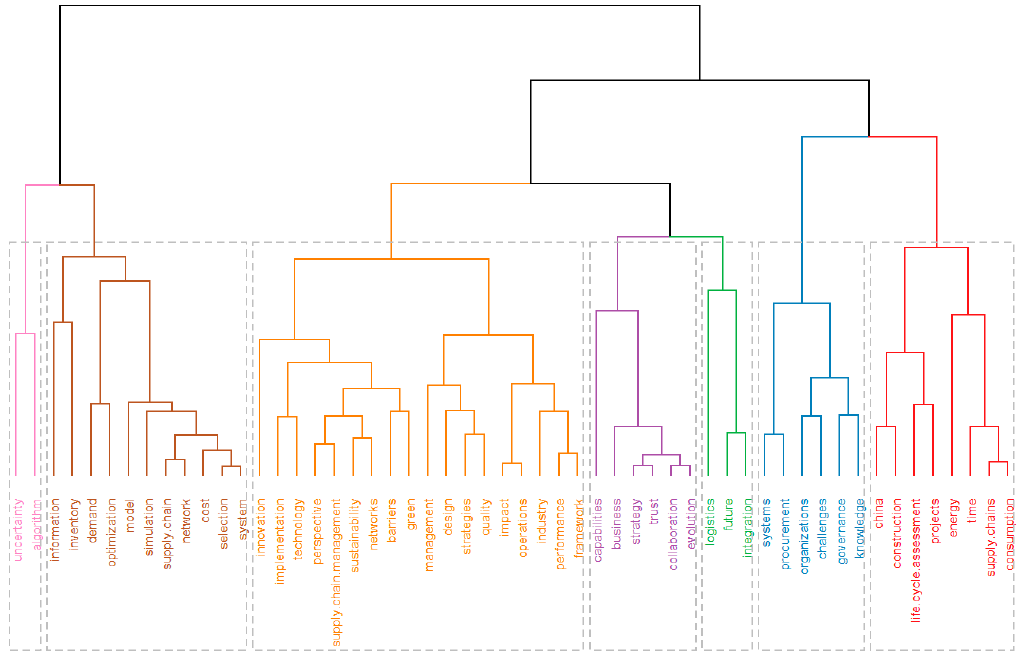
Figure 9 . Hierarchical clustering of keywords in CSCM domain dendrogram .